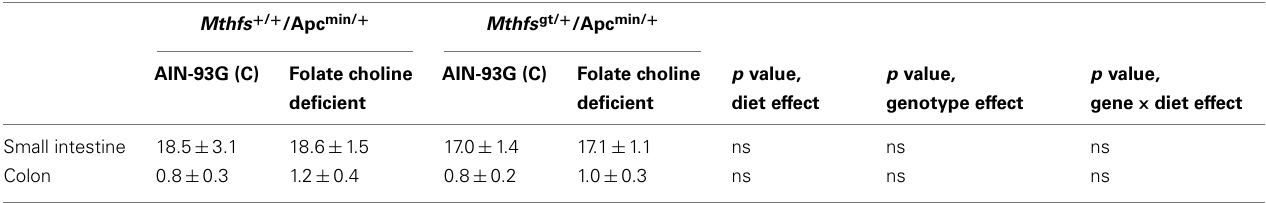
Table 4 | Tumor number in small intestine and colon of and Mthfs + / + /Apc min/ + Mthfs gt/ + /Apc min/ + after 11weeks onAIN-93G andAIN-93G lacking folate and